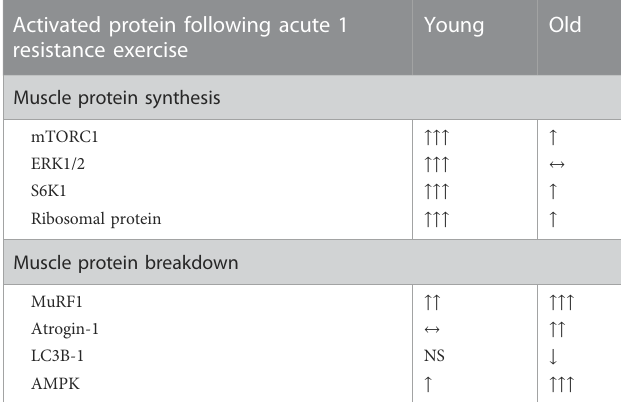
TABLE 1 Activated protein following acute resistance